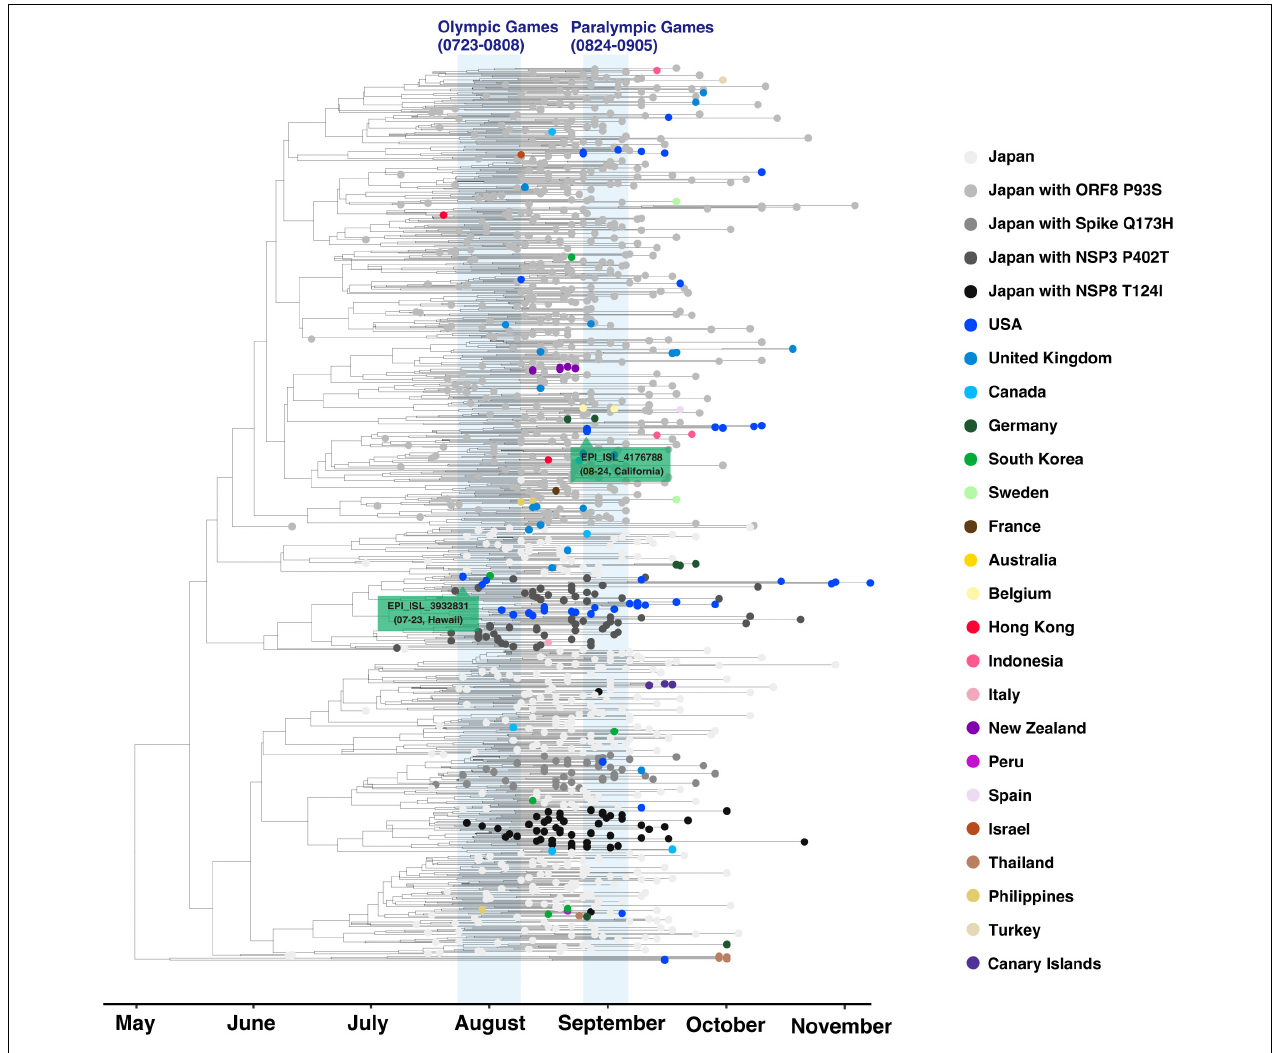
FIGURE 3 | Phylogenetic analysis of AY.29 strains. All overseas samples were combined with randomly selected 1,000 AY.29 genomes in Japan. The exported strains of the two largest clusters in the AY.29 exported strains were labeled in